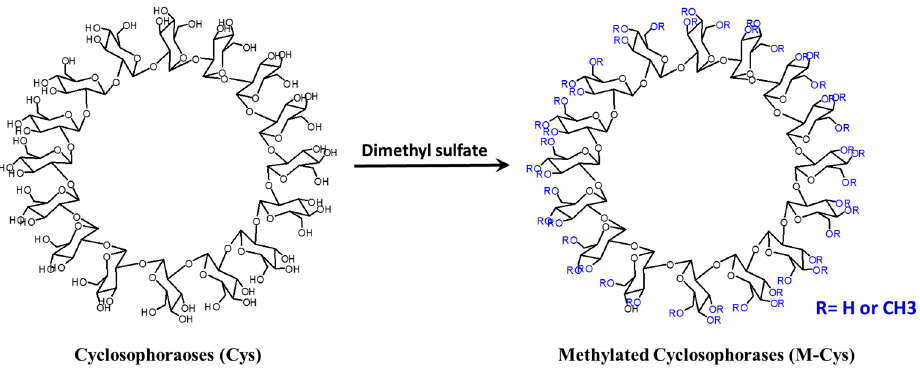
Figure 5. Synthesis of methylated Cys starting from Cys.